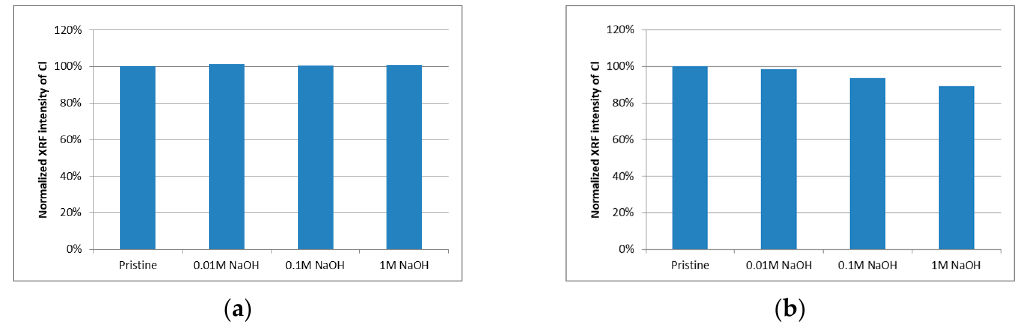
Figure 7. Normalized chlorine intensities obtained using XRF measurements before and after immersion in solutions of different alkali concentrations ( a ) CMX ( b ) AMX.